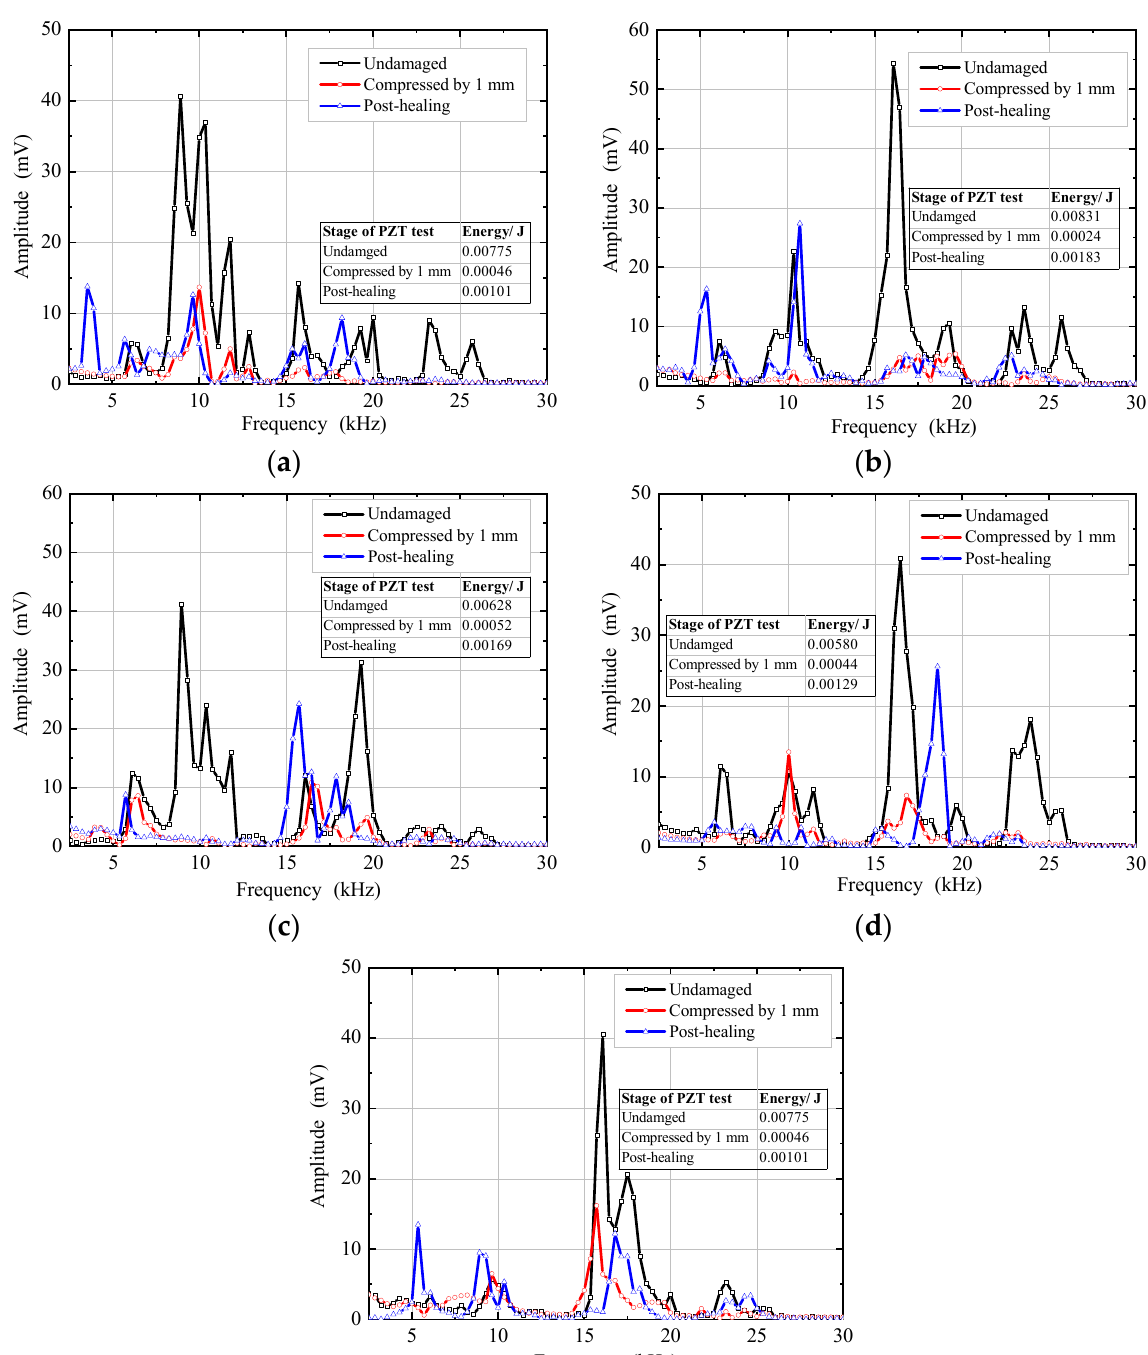
Figure 14. Frequency spectrum of microcapsules in various water environments: ( a ) pH = 1; ( b ) pH = 3; ( c ) pH = 5; ( d ) pH = 9; ( e ) pH =